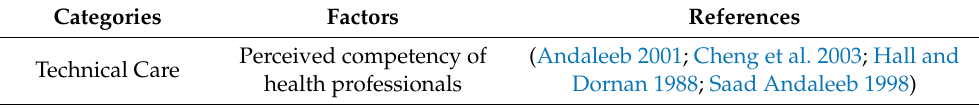
Table 1. Factors affecting patient satisfaction in the COVID-19 pandemic crisis.